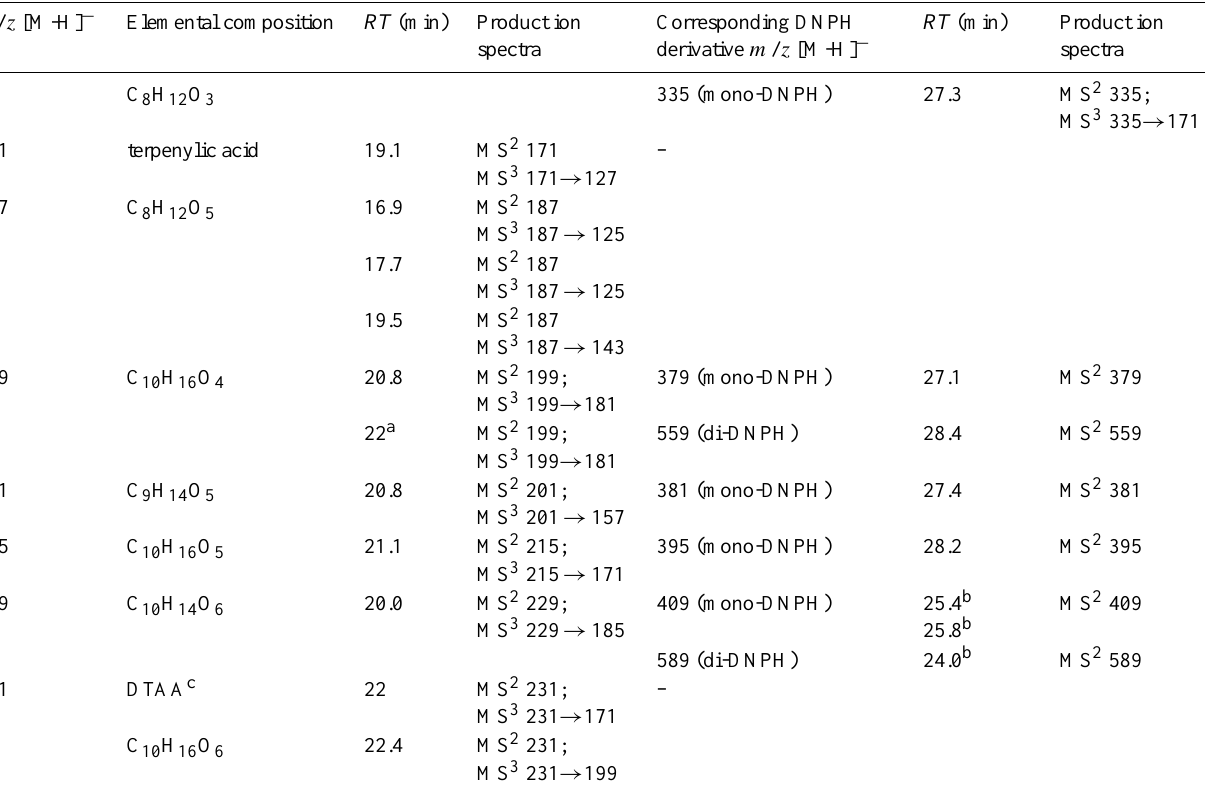
Table 5. List of products with matching RT observed from campholenic aldehyde/O 3 , α -pinene oxide/O 3 /acidic seed, α -pinene/O 3 and a K-puszta filter sample, including their corresponding DNPH derivatives (when appropriate). The table summarises all the mass spectral data recorded in the present study.